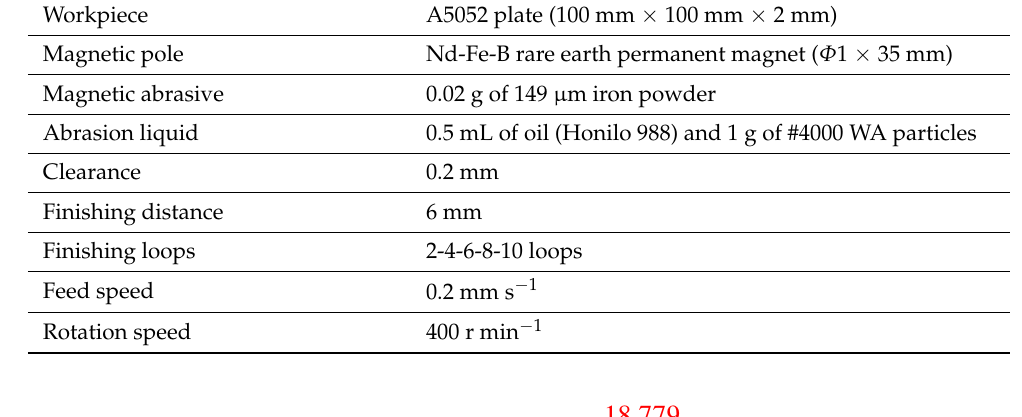
Table 1. Experimental conditions of evaluating finishing efficiency.